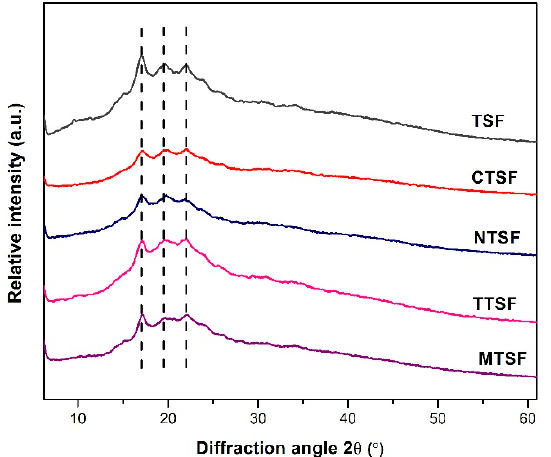
Figure 2. XRD of biodegradable composite films with and without plant